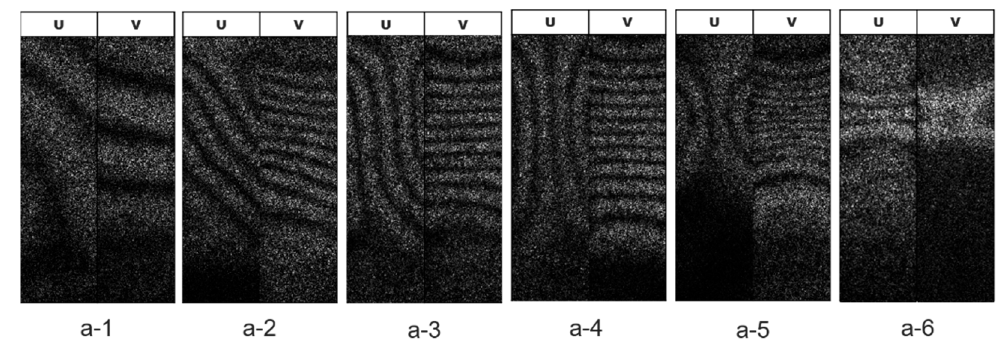
Figure 8. Evolution of fringe patterns observed in tensile test of 7075-T6 alloy. Images (a-1 to a-6) show the patterns observed at the strains marked in Figure 7.